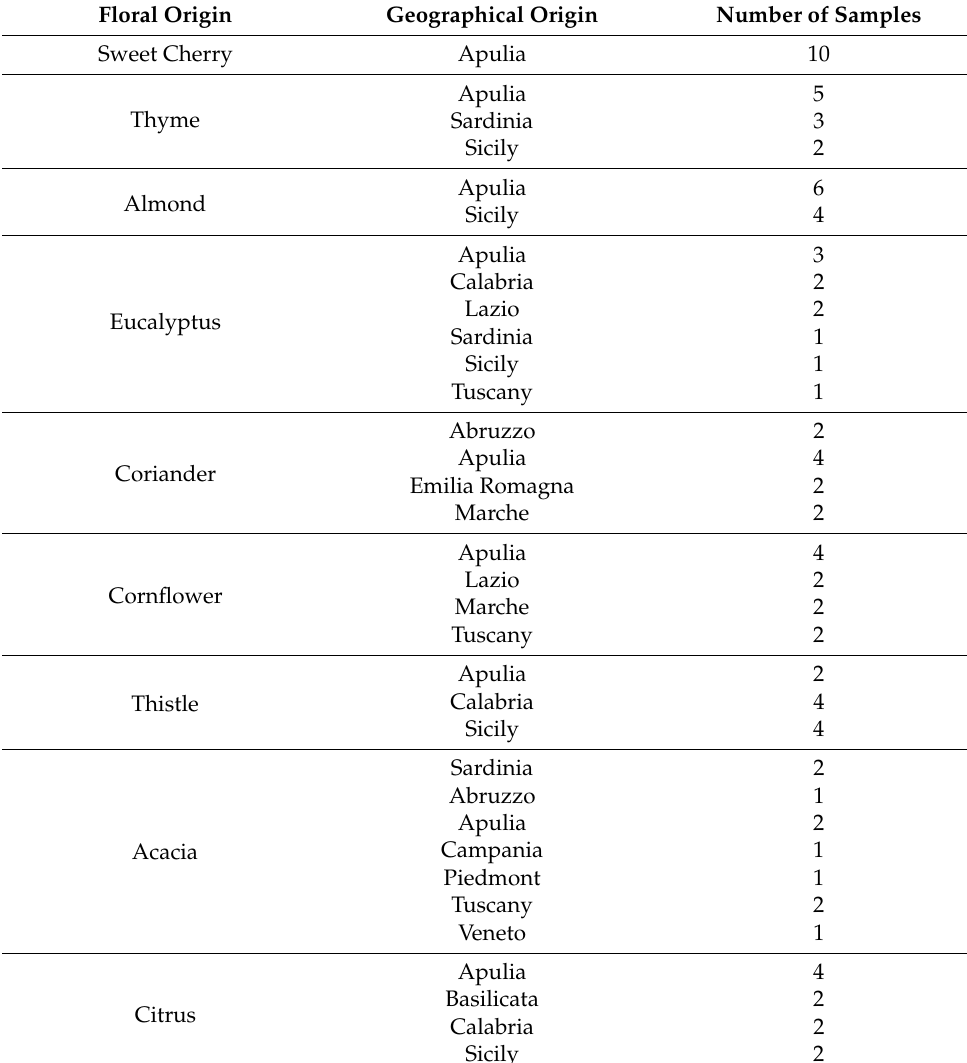
Table 1. Geographical origin of Italian